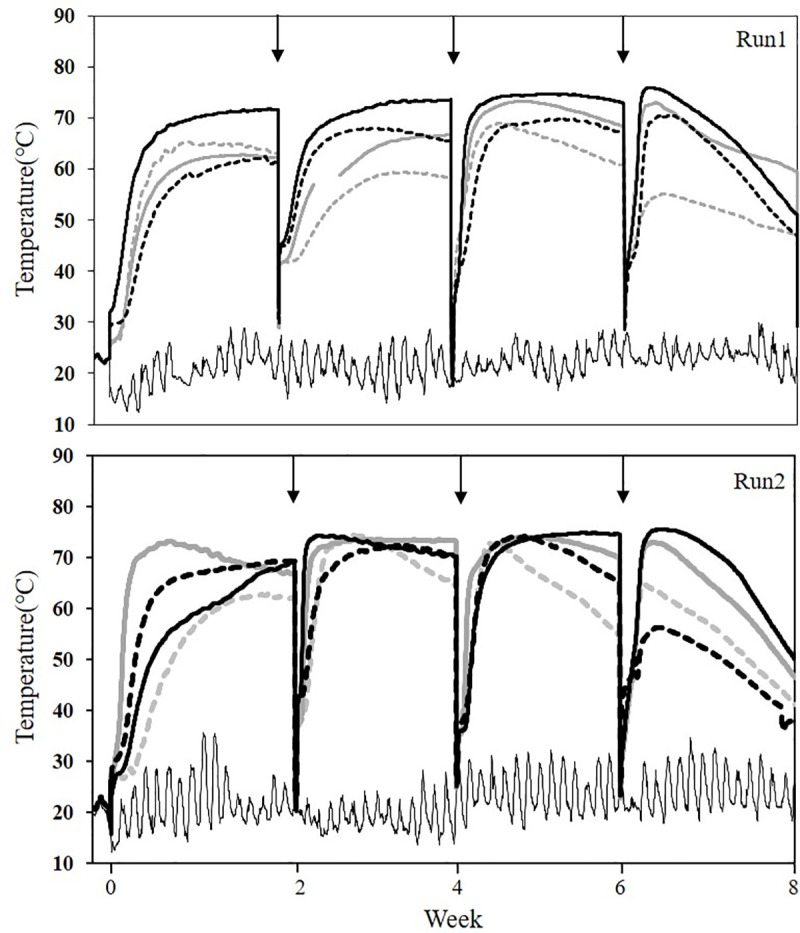
Temperature profiles of compost piles.Black solid lines, CS core; black dashed lines, CS bottom; light grey bold lines, WS core; light grey dashed lines, WS bottom; thin black lines, ambient temperature. Arrows indicate pile turnings.